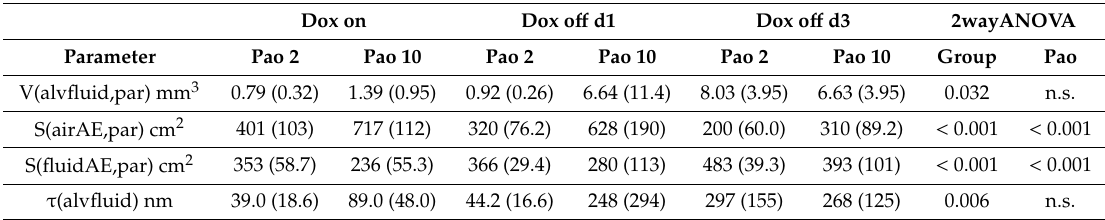
Table 3. Alveolar